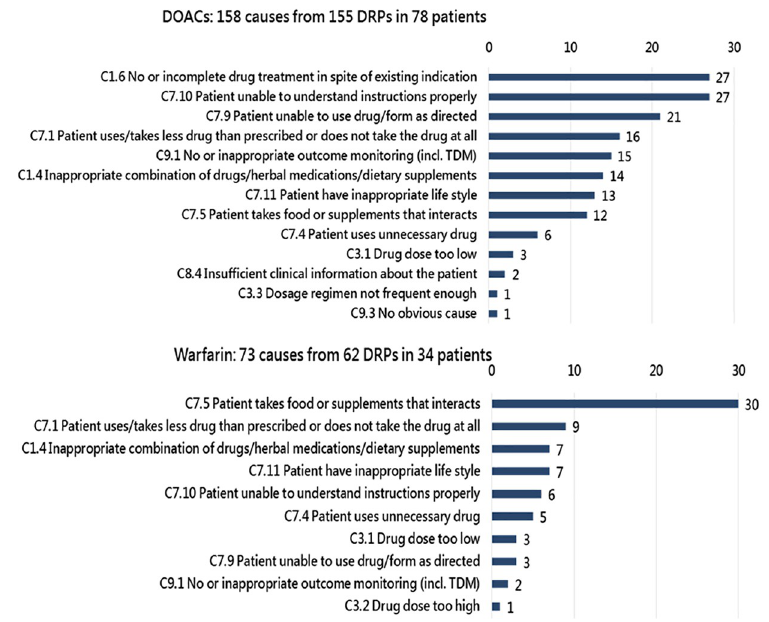
Fig 2. Identified causes of DRPs according to the PCNE-DRP classification tool version 9.0. DOACs, direct oral anticoagulants; DRP, drug-related problem; PCNE, Pharmaceutical Care Network Europe; TDM, therapeutic drug